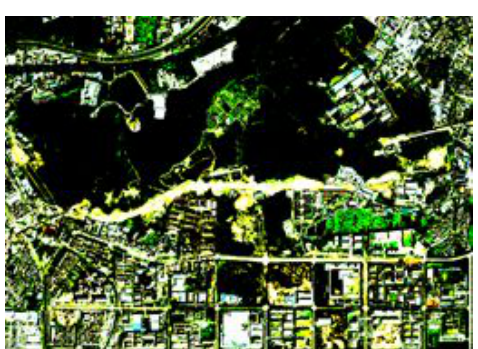
Figure 1. Pleiades image in 2012